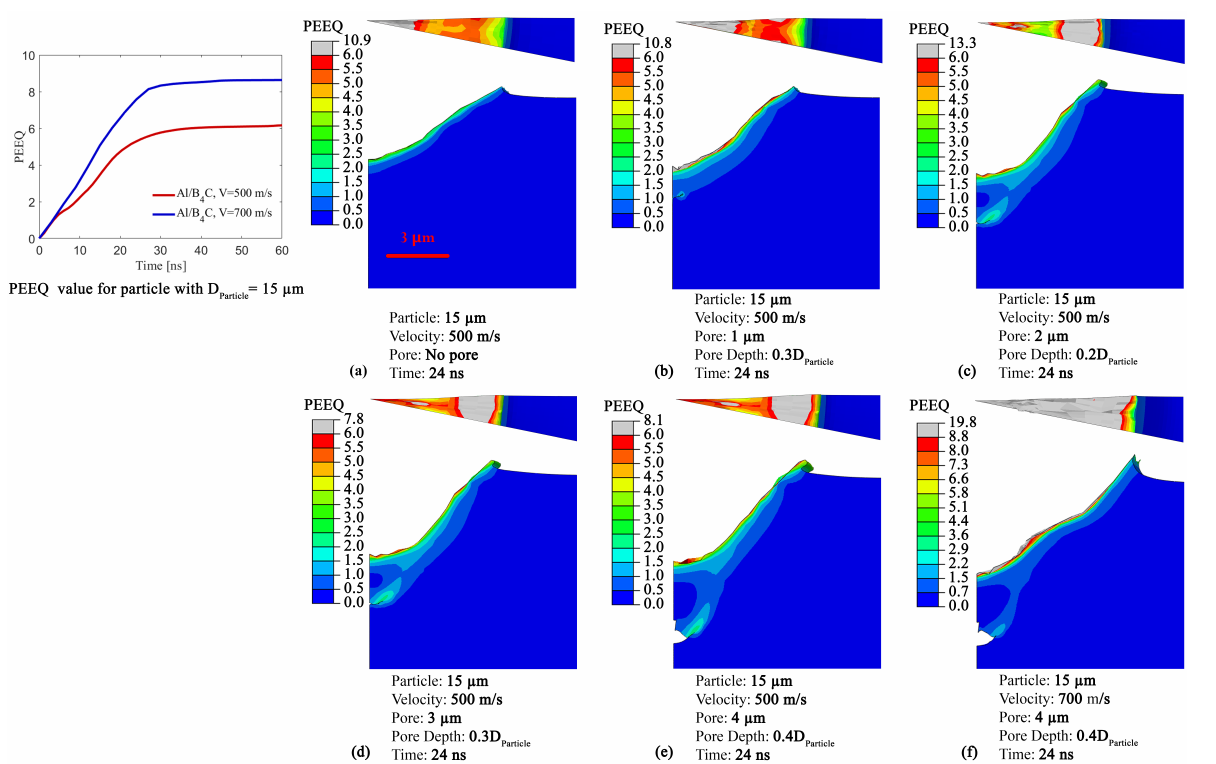
Figure 6. Comparison of the substrate crater morphology for D Particle = 15 µ m cases of ( a ) With- out pore and V Impact = 500 m/s. ( b ) With pore of D Pore = 1 µ m at a depth of 0.3 D Particle and V Impact = 500 m/s. ( c ) With pore of D Pore = 2 µ m at a depth of 0.2 D Particle and V Impact = 500 m/s. ( d ) With pore of D Pore = 3 µ m at a depth of 0.3 D Particle and V Impact = 500 m/s. ( e ) With pore of D Pore = 4 µ m at a depth of 0.4 D Particle and V Impact = 500 m/s. ( f ) With pore of D Pore = 4 µ m at a depth of 0.4 D Particle and V Impact = 700